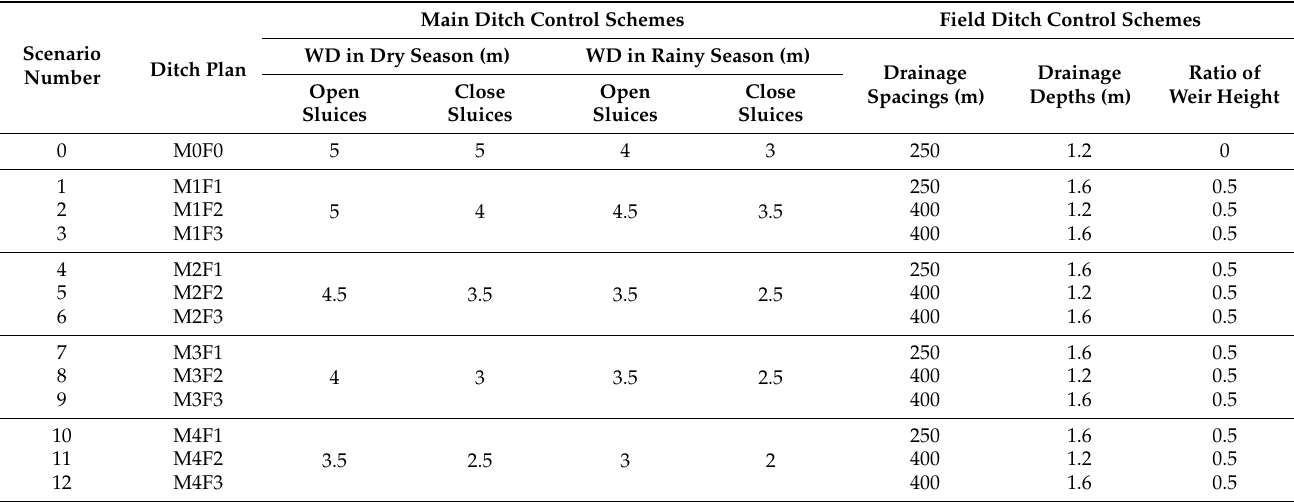
Table 3. Combined main ditch and field ditch control